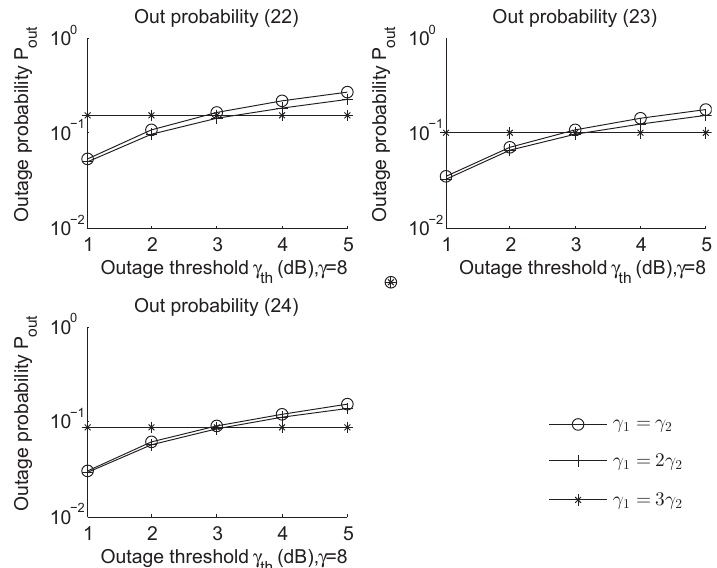
Figure 9. The outage probability with different expressions vs. different outage thresholds, γ th , for γ 1 = γ 2 ,2 γ 2 , and 3 γ 2